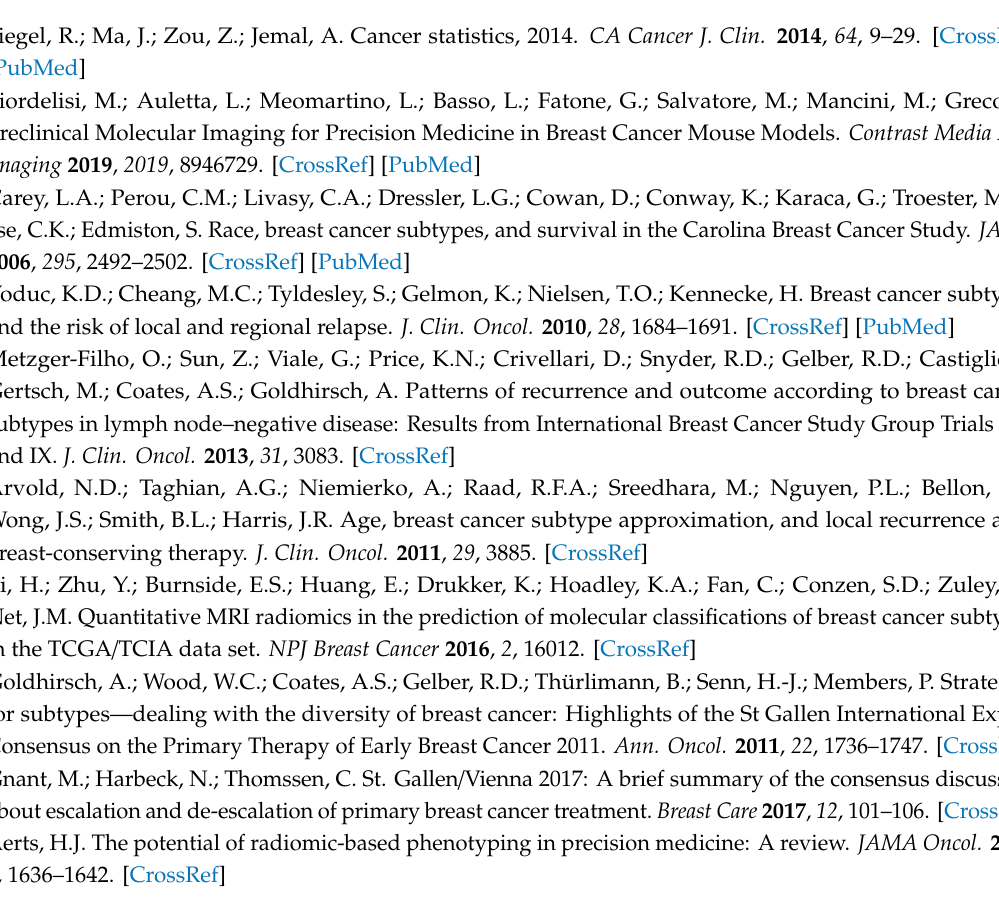
Figure S1: Relationship between breast cancer miRNAs expression and ER receptor status; Figure S2: Relationship between breast cancer miRNAs expression and PR receptor status; Figure S3: Relationship between breast cancer miRNAs expression and HER2 receptor status; Figure S4: Relationship between breast cancer miRNAs expression and TN cases; Figure S5. Box plots of radiomic features chosen by the machine learning methods to automatically detect ER status; Figure S6: Box plots of radiomic features chosen by the machine learning methods to automatically detect PR status; Figure S7: Box plots of radiomic features chosen by the machine learning methods to automatically detect HER2 receptor; Figure S8: Box plots of radiomic features chosen by the machine learning methods to automatically detect TN cases. Table S1: Additional Clinical Parameters; Table S2: Radiomic Features; Table S3: Correlation Analysis on the Whole Dataset between Non-Normalized and Normalized Radiomic Features; Table S4: Imaging-genomic associations; Table S5: Support Vector Machine Performance on Testing dataset ER + vs ER–; Table S6: Random Forest Performance on Testing dataset ER + vs ER–; Table S7: Naïve Bayesian Performance on Testing dataset ER + vs ER–; Table S8: Support Vector Machine Performance on Testing dataset PR + vs PR–; Table S9: Random Forest Performance on Testing dataset PR + vs PR–: Table S10: Naïve Bayesian Performance on Testing dataset PR + vs PR–; Table S11: Support Vector Machine Performance on Testing dataset TN vs Others; Table S12: Random Forest Performance on Testing dataset TN vs Others; Table S13: Naïve Bayesian Performance on Testing dataset TN vs